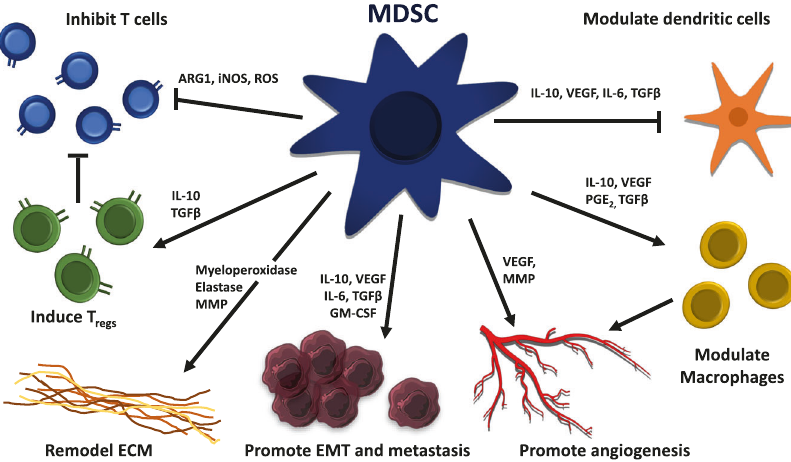
Fig. 3 An overview of malignancy-associated mechanisms promoted by myeloid-derived suppressor cells. MDSCs inhibit CD4 and CD8 T cells while inducing regulatory T cells (Tregs). Through matrix metalloproteinases, MDSC promotes angiogenesis and enhances metastasis through anti-in fl ammatory mediators such as TGF- β and IL-10. Through IL-10, MDSCs also modulate dendritic cells and macrophages. ARG1 Arginase-1, ECM extracellular matrix, EMT epithelial – mesenchymal transition, INOS inducible nitric oxide synthetase, MMP metalloproteinase, GM-CSF granulocyte/macrophage colony-stimulating factor, PG prostaglandin E, VEGF vascular endothelial growth